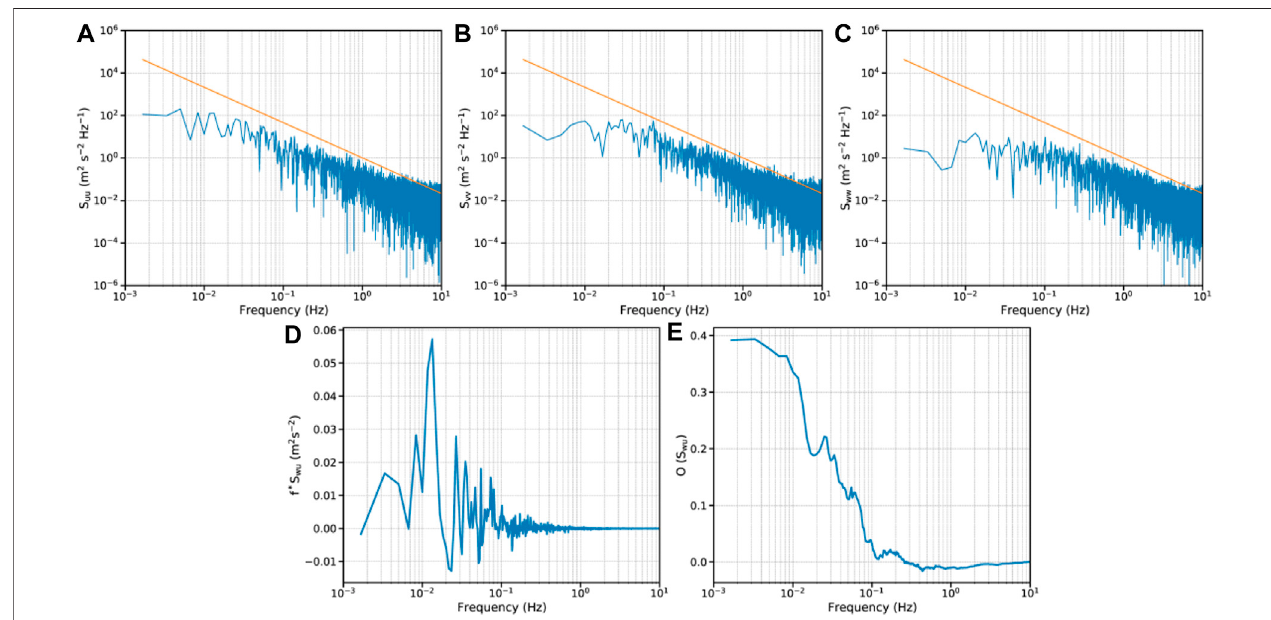
FIGURE 3 | (A – C) Plots of the power spectra for the three-dimensional wind velocities at z = 72 m from a good fl ux run of Typhoon Fanapi. The orange lines represent the -5/3 slope. Plots of the (D) cospectra and (E) cumulative summations of cospectra of along-wind momentum fl ux from this good fl ux run.